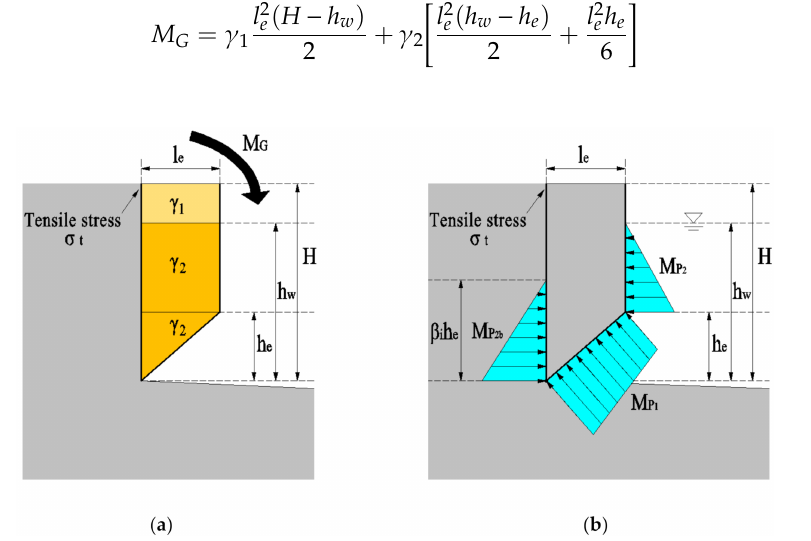
M . ( b ) Moments of force due to water G